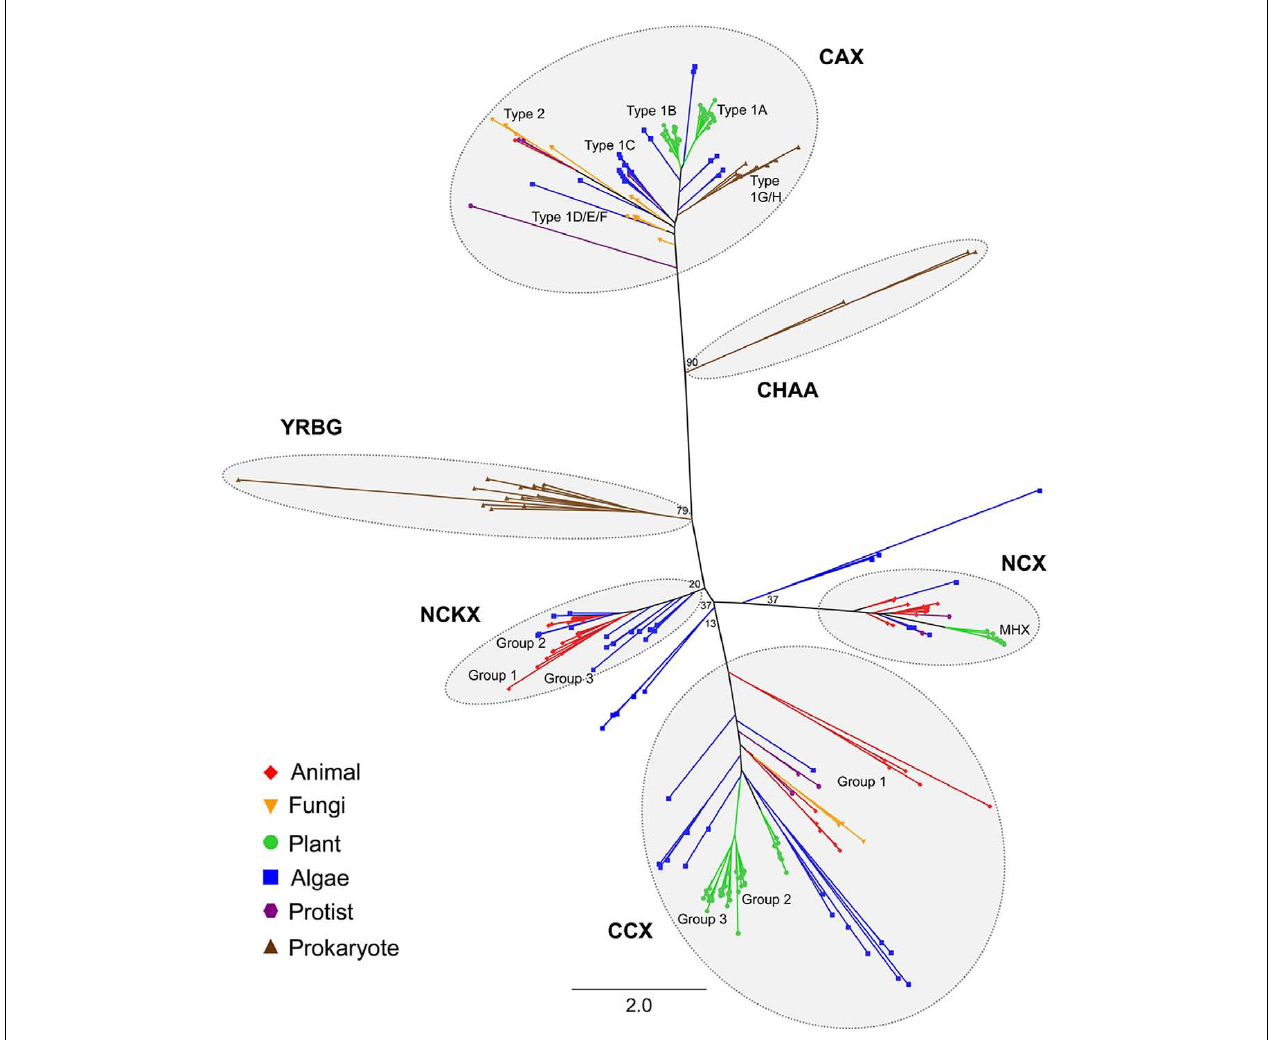
The sub-groups determined for the CAX, CCX, NCX, and NCKX families as shown in Figures 4 , 6 , 7 , and 9 , are also given. Line colors and symbols denote the species class. Bootstrap values are indicated at the nodes of major branches.The branch length scale bar indicates the evolutionary distance of two amino acid substitutions per